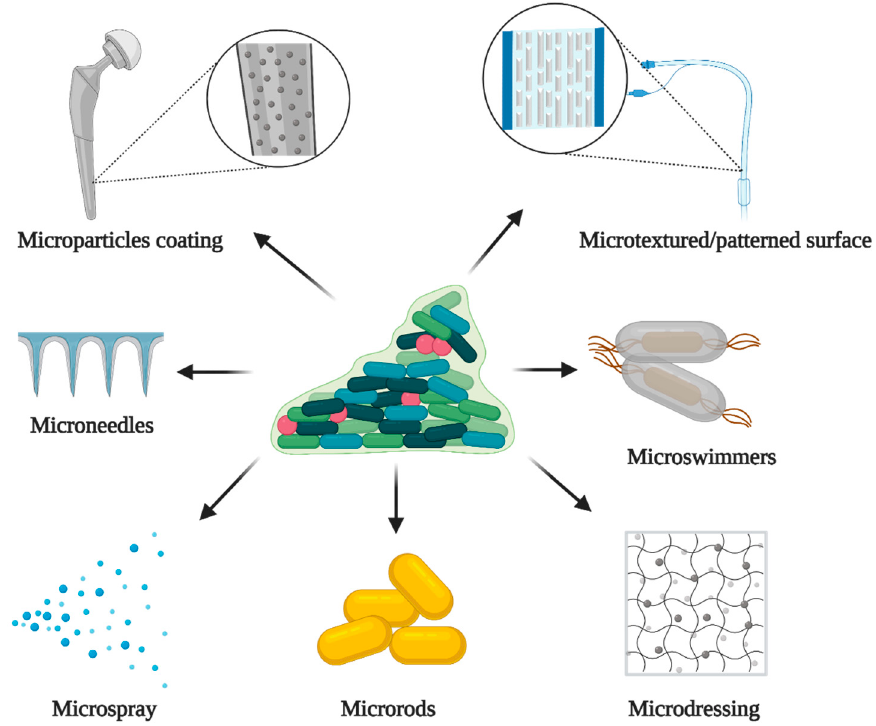
Figure 3. Novel microtechnology approaches to combat biofilms and as drug delivery systems.